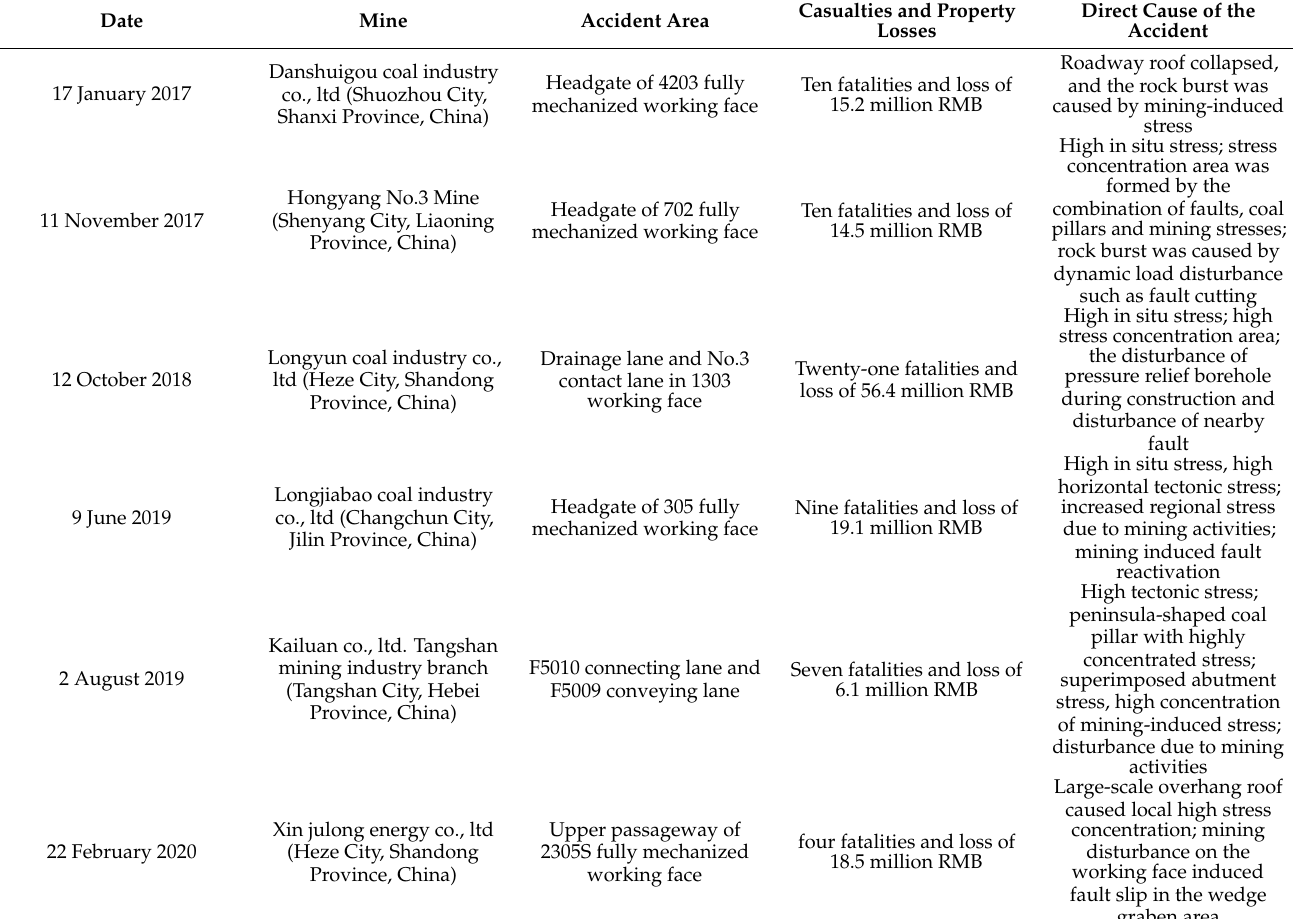
Table 1. Major rock burst disasters occurred in China the past five